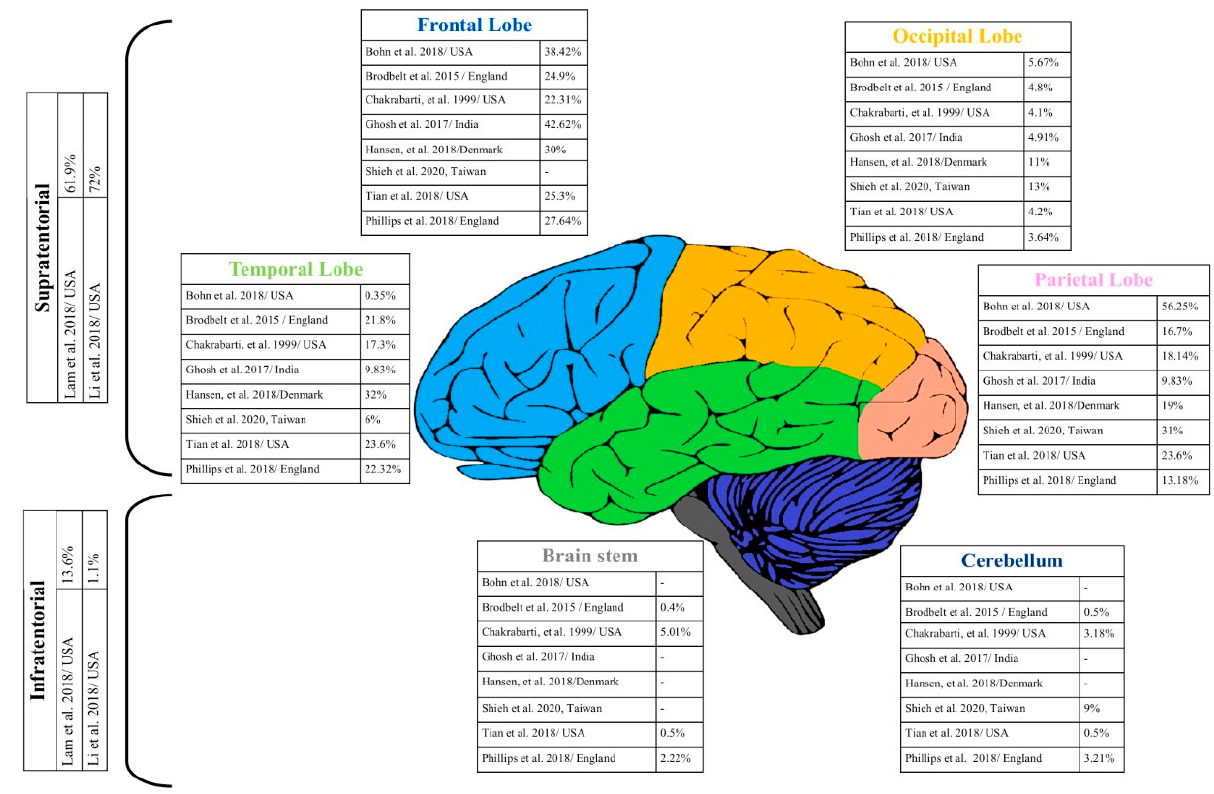
Figure 1. Summary of GBM locations in the central nervous system (%); some data also distinguished locations: Brain, NOS (not otherwise specified), Chamber NOS (not otherwise specified), Brain Overlapping Brain Damage, and Other, which are not shown in the figure; therefore, the sum of the percentages of the structures is not 100% [23,24,26–32]. own figure, no permission required for publication.